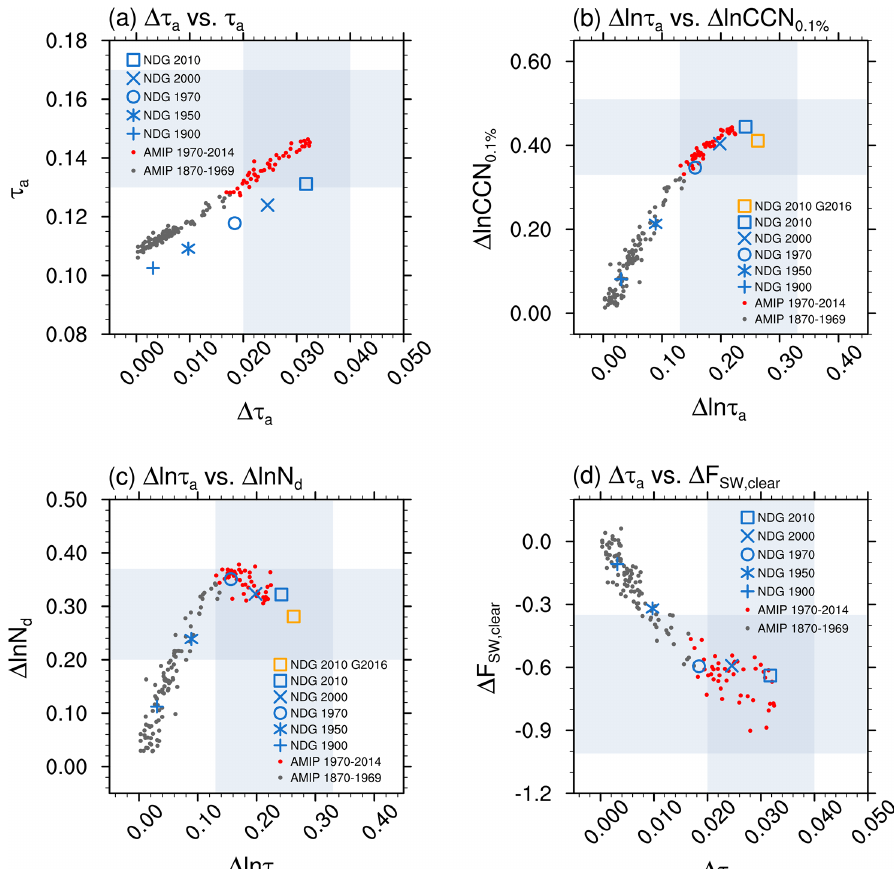
Figure 7. Relationships between simulated anthropogenic AOD ( (cid:49)τ a ) and present-day total AOD ( τ a ), relative (PD-PI) changes in AOD ( (cid:49) ln τ a ) and in the column-integrated CCN at 0.1% supersaturation ( (cid:49) lnCCN 0 . 1% ), (cid:49) ln τ a and relative changes in the column-integrated N d ( (cid:49) ln N d ), and (cid:49)τ a and changes in clear-sky shortwave radiation ( (cid:49) F SW , clear ). (cid:49) ln X = (cid:49)X/X PD . Dark grey dots indicate estimated values from AMIP PD/PI simulations for the years 1870–1969, while red dots are the estimated values for the years 1970–2014. Each dot represents the ensemble-averaged global annual mean field for a certain year. Blue markers show the estimates based on nudged simulations. The orange square shows the nudged simulation results averaged from conditionally sampled high-frequency data following Ghan et al. (2016), wherein CCN (at 0.3% supersaturation) and N d are sampled below 1km and at the top of liquid clouds. Grey areas in panels (a, d) indicate the multi-model estimated range from Bellouin et al. (2020) and in panels (b, c) the multi-model estimated range from Ghan et al. (2016). See Sect. 4.1 for